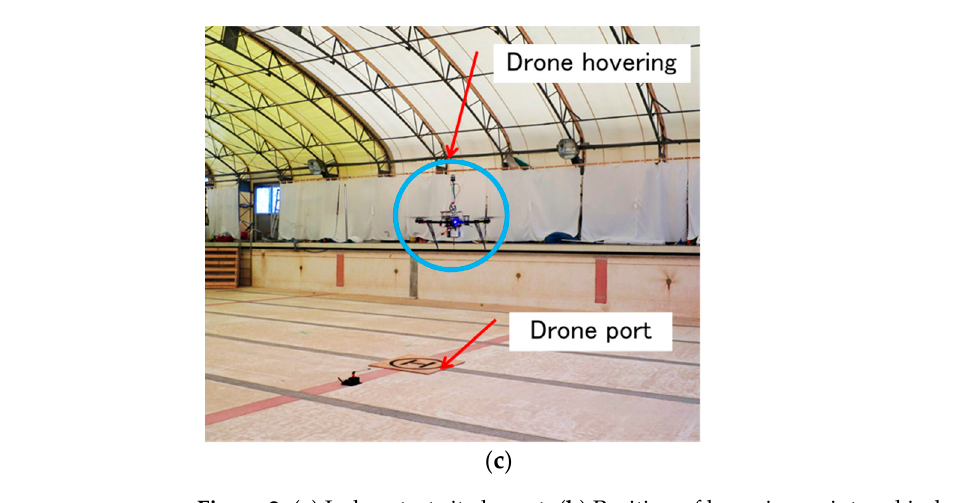
Figure 2. ( a ) Indoor test site layout. ( b ) Position of hovering point and indoor wind measurement point (except for Run A-1). ( c ) Drone hovering at a height of 2 m. The background wind measurement point was replaced after the first run (Run A-1) to avoid a collision accident with a drone.